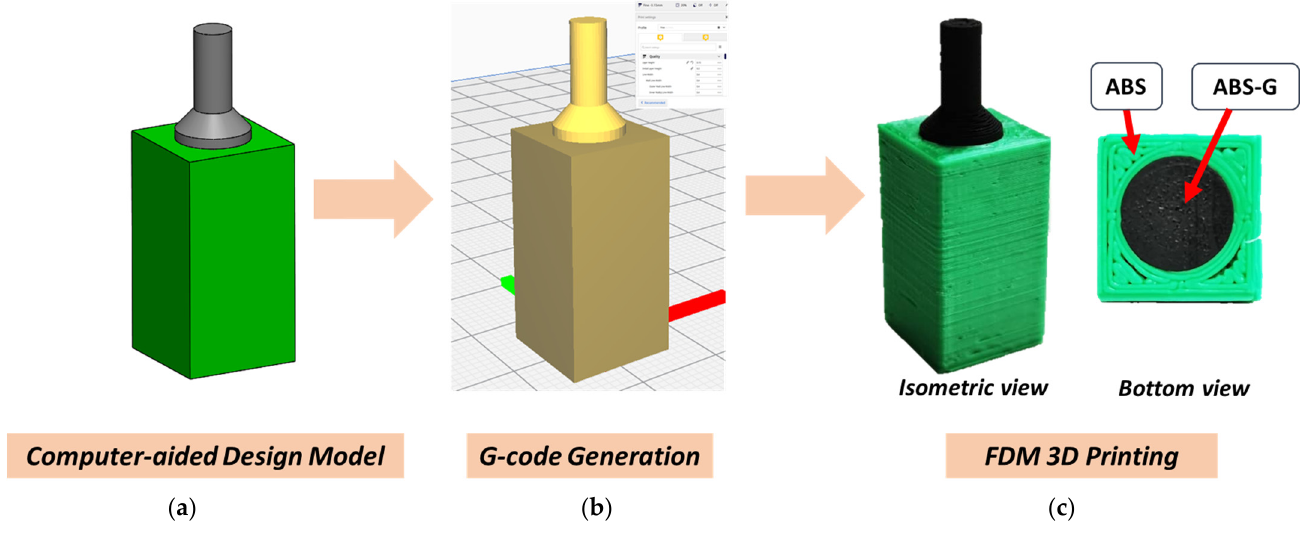
Figure 1. Fabrication process of 3D printed composite electrode. ( a ) Computer-aided design model, ( b ) G-code generation, ( c ) FDM 3D printing.